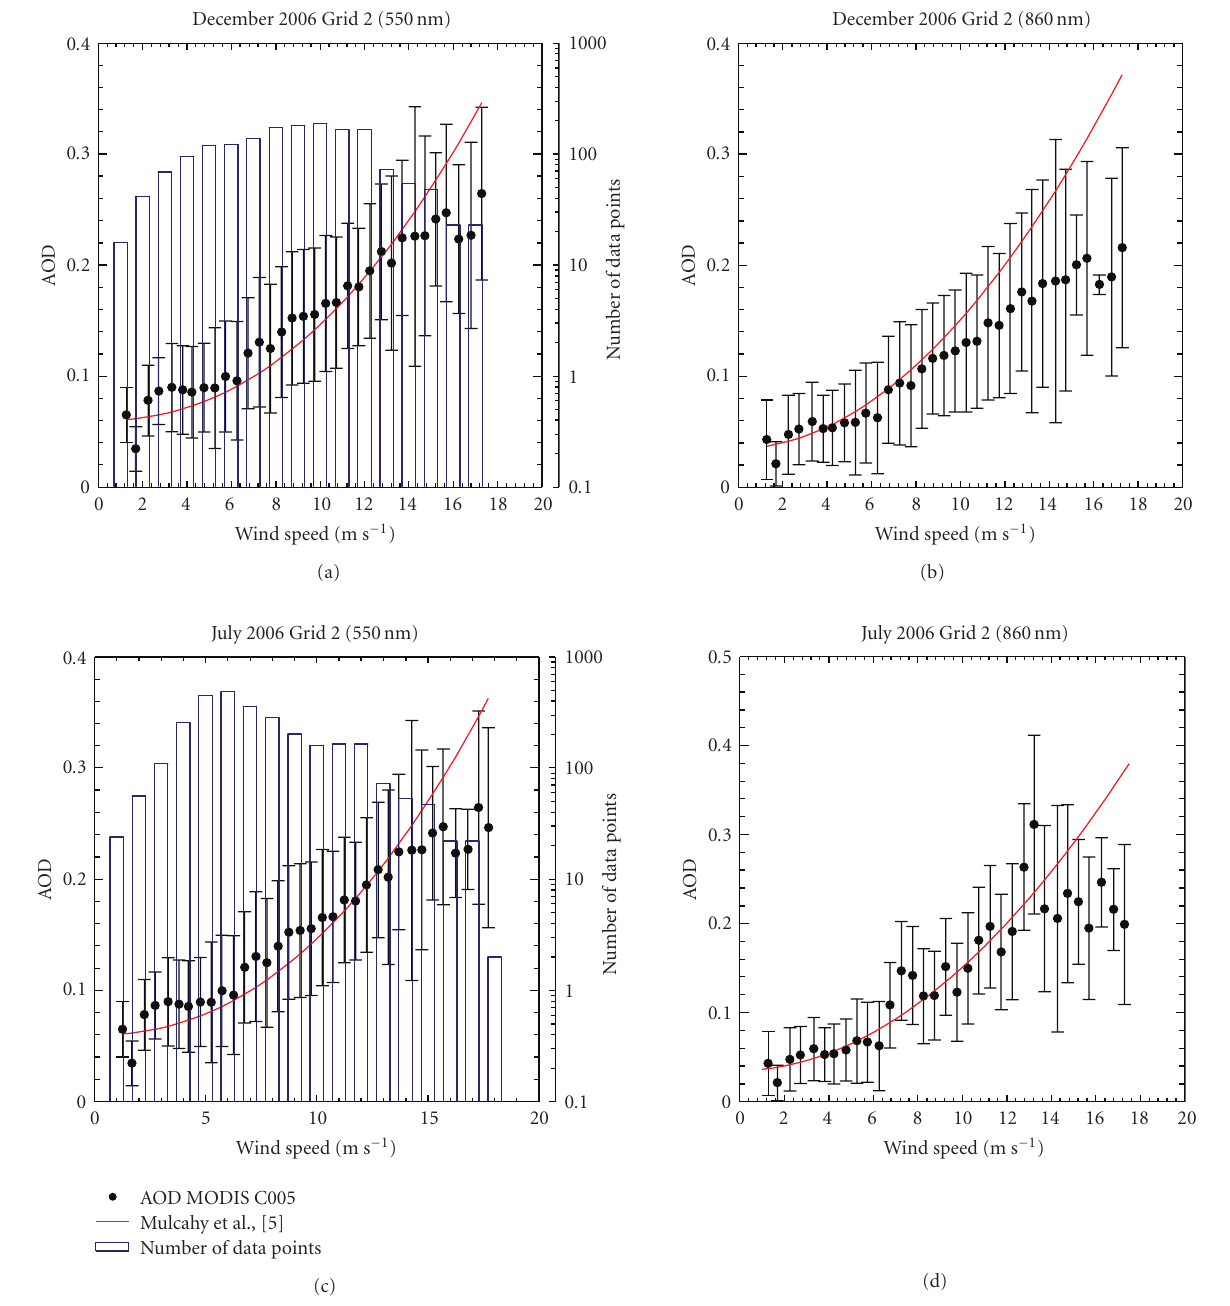
Figure 3: This Figure compares MODIS C005 AOD data at 550nm and 860 nm (together with the standard deviation of AOD data within each bin) for Grid 2 during December and July 2006 with the Mulcahy et al. [5] AOD-wind speed